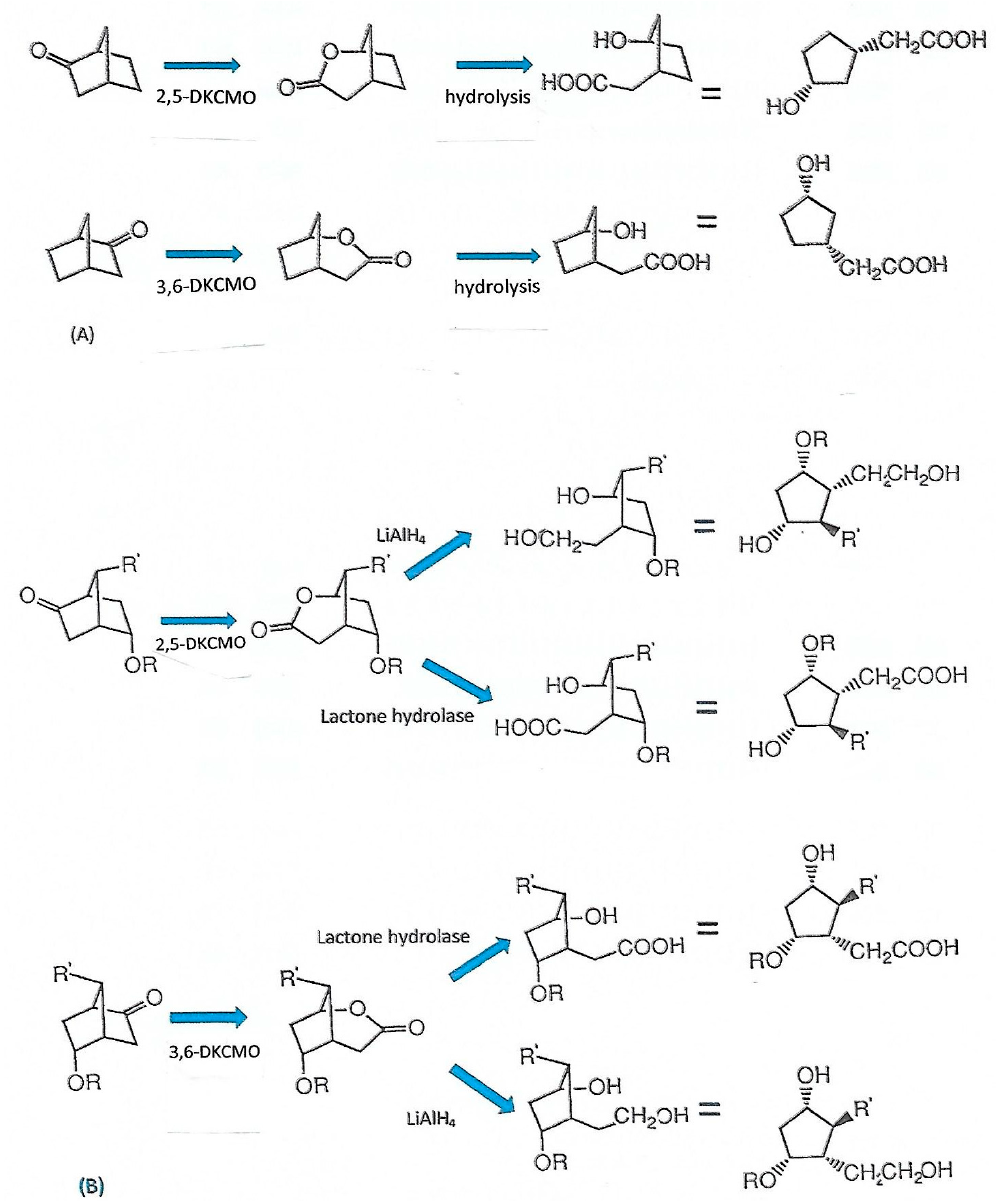
Figure 13. ( A ). Generation of enantiocomplementary substituted cyclopentanes with two chiral centres by deploying DKCMO-catalysed biotransformations of unsubstituted ( rac )-bornan-2-one as a key step. ( B ). Generation of enantiocomplementary substituted cyclopentanes with four chiral centres by deploying DKCMO-catalysed biotransformations of ( rac )-5’,7’-disubstituted bicyclo[2.2.1] ketones as a key step.